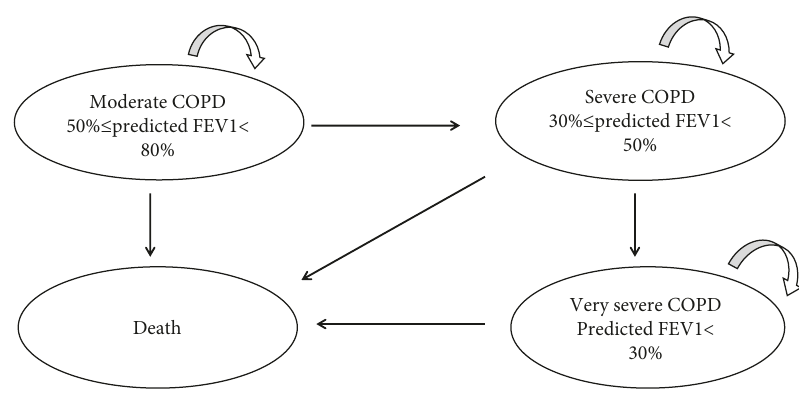
Figure 1: Structure of the decision model used. Table 1: Baseline characteristics of the population included in the